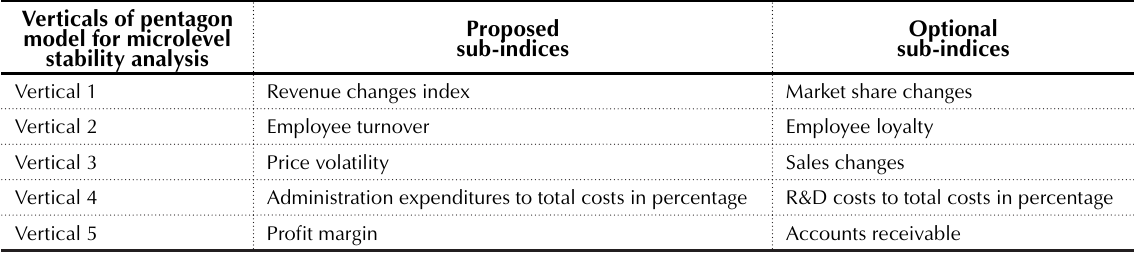
Table 1. The optional alternatives for the indices of the pentagon model t Verticals of pentagon model for microlevel stability analysis